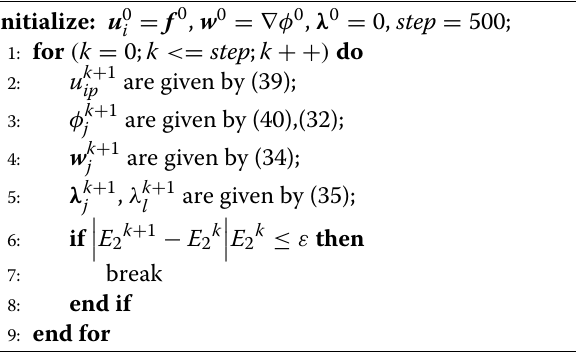
Algorithm 2 ADMM of modified Vese-Chan model for color